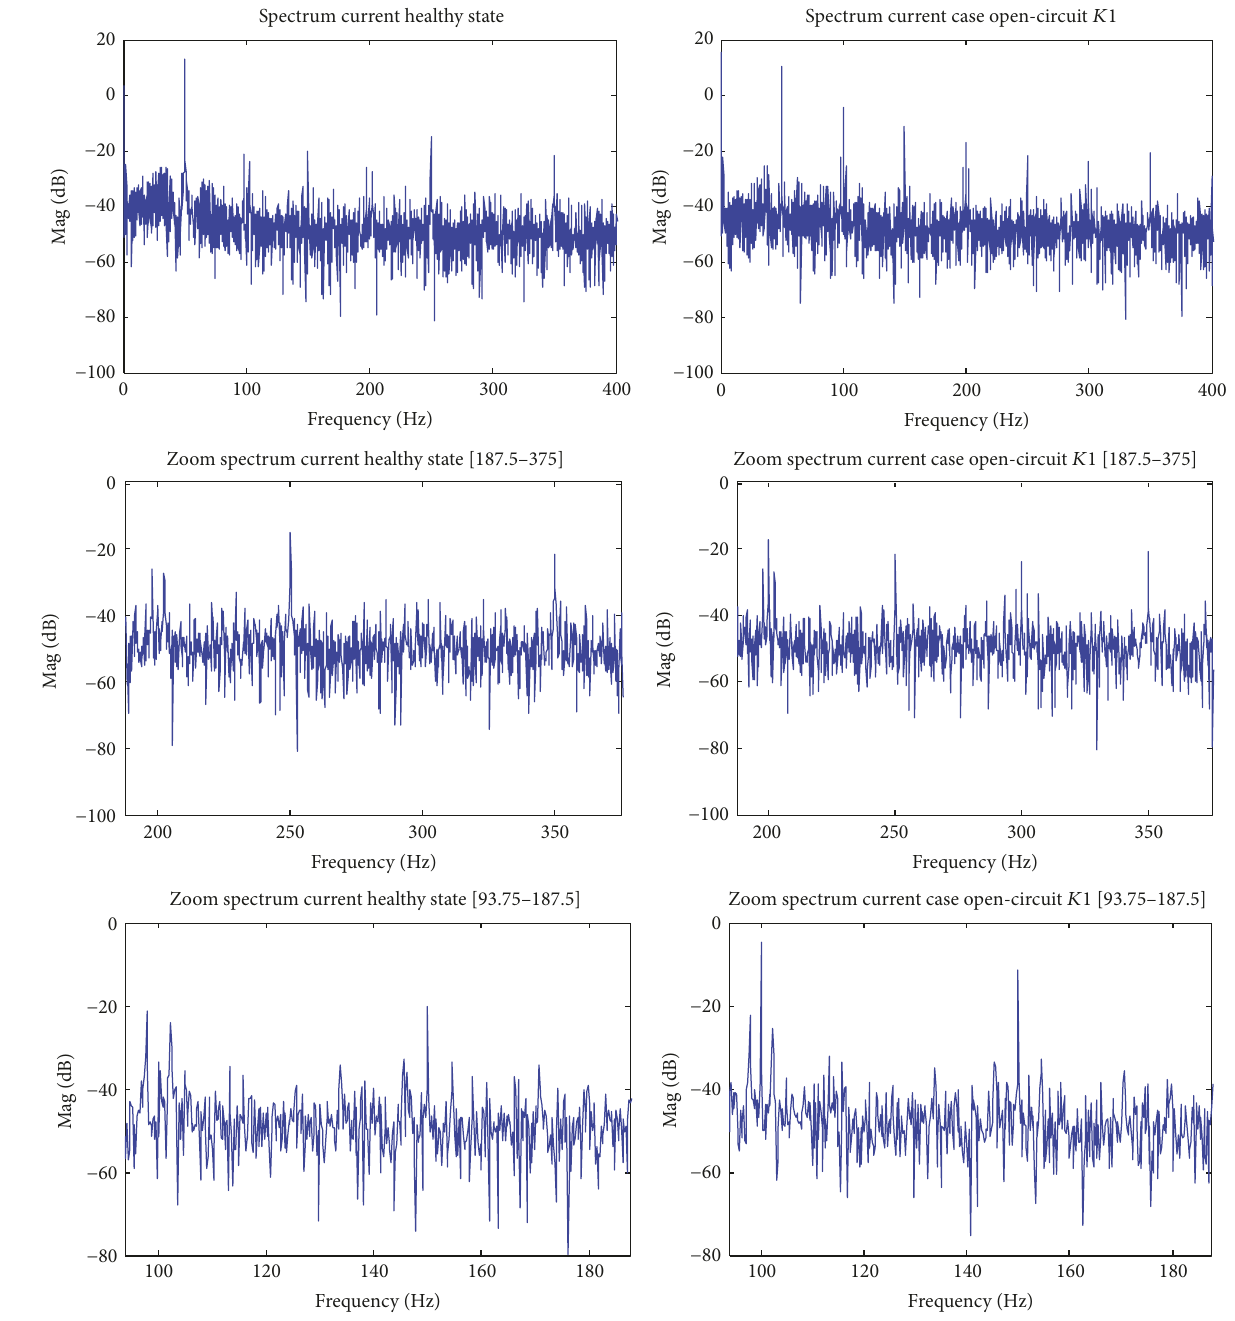
Figure 12: FFT of stator current signal for healthy and faulty open-circuit at 𝐾 1 cases.